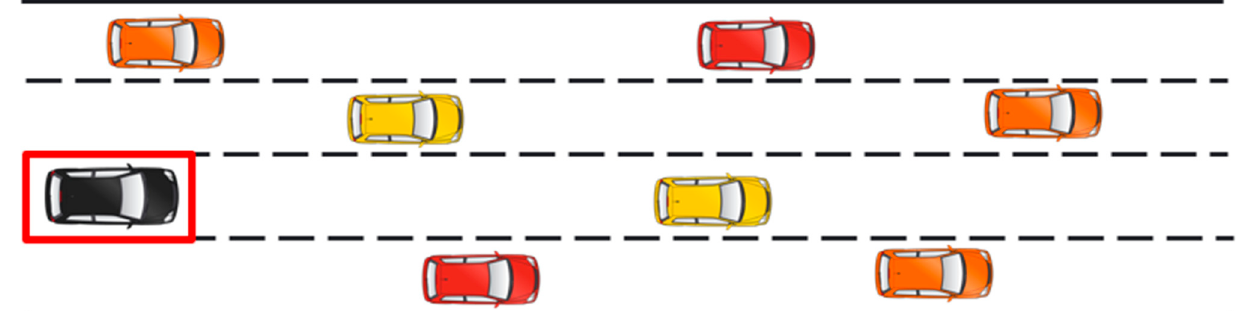
Figure 4. The highway environment (vehicle in the red box is ego-vehicle).